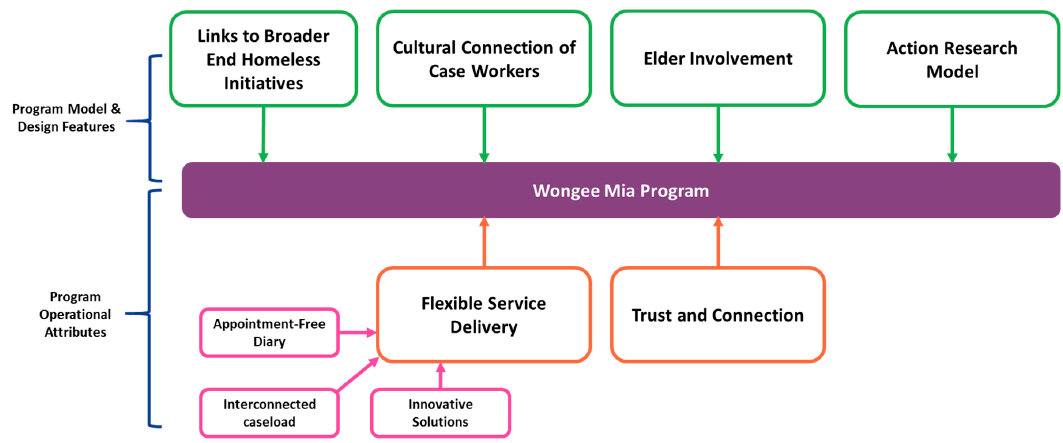
Figure 2. Key elements of the Wongee Mia model.